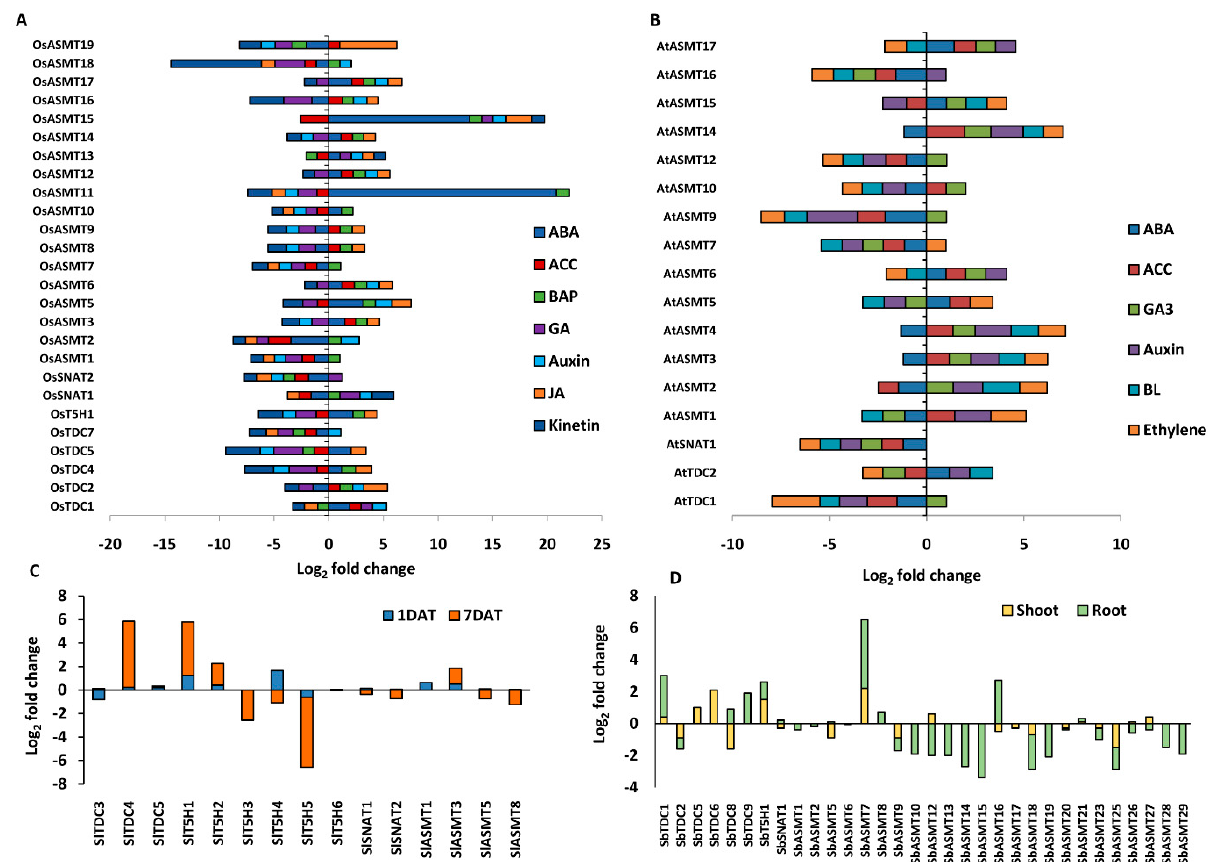
Figure 7. Phytohormone-mediated regulation of genes encoding Ser and Mel biosynthetic enzymes in different plant species. Stacked bar plots depicting expression profile of genes encoding Ser and Mel biosynthetic enzymes in ( A ) rice, ( B ) Arabidopsis and ( C ) tomato (Auxin-treated) was obtained from the publicly available Genevestigator database and supplementary data of corresponding studies. Perturbation data for the genes in ( D ) Sorghum (ABA-treated) was obtained from the Expression Atlas database. DAT, days after auxin treatment. ABA, Abscisic acid; ACC, 1-aminocyclopropane-1-carboxylic acid; BAP, Benzylaminopurine; GA, Gibberellic acid; JA, Jasmonic acid; IAA, Indole acetic acid; BL, Brassinolide.